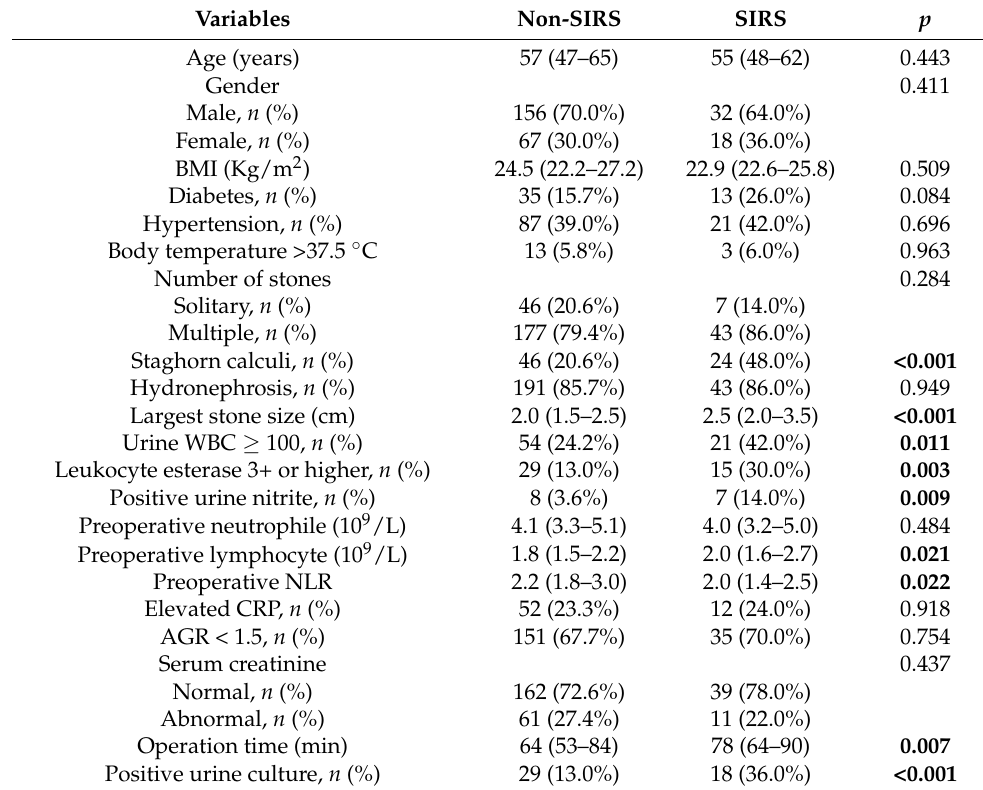
Table 2. Clinical and preoperative factors between SIRS and non-SIRS